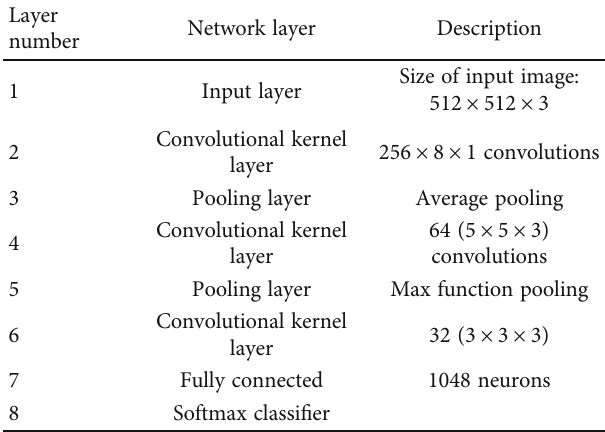
Table 4: CNN architecture describing network